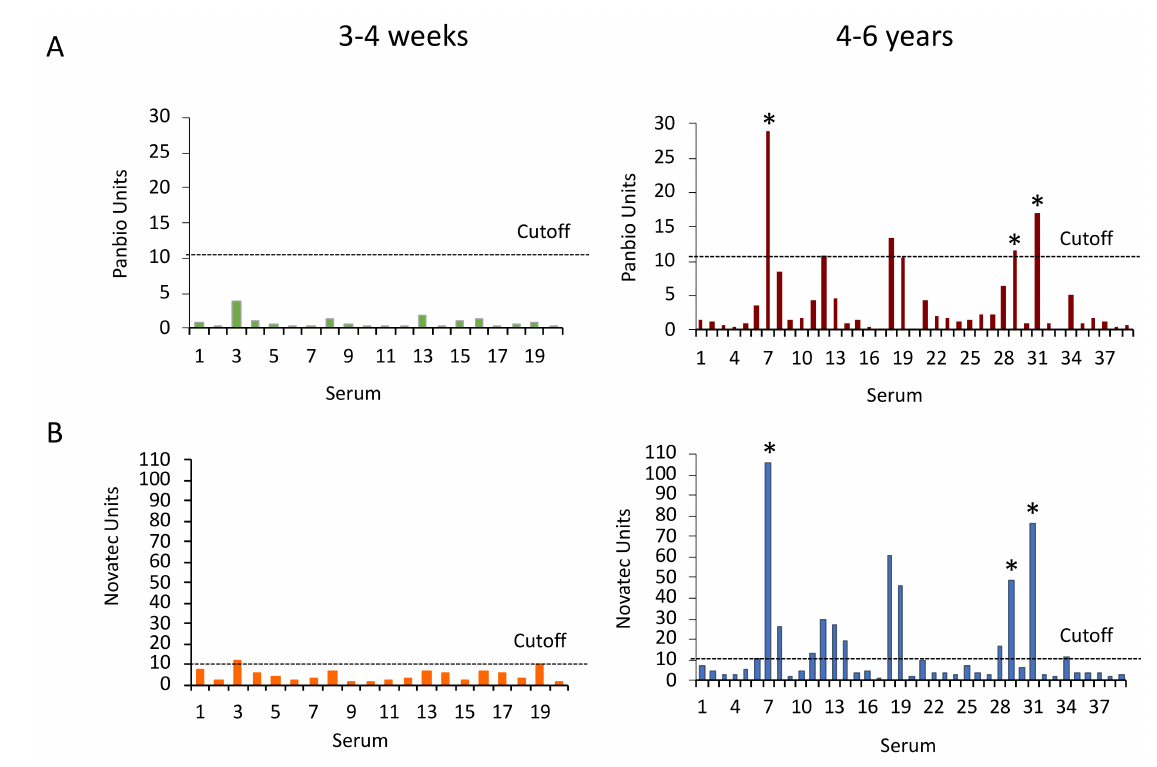
Figure 3. Panbio and NovaLisa Dengue IgG ELISA reactivity with sera from YFV-vaccinated individuals. ( A ) Panbio and ( B ) NovaLisa ELISA units with sera from 3–4 weeks (N = 20) and 4–6 years (N = 39) after YFV vaccination. Original Panbio measurement units were multiplied by 10. The dotted line indicates the cut-off for positive sera (11 assay units). Asterisks show sera that neutralized DENVs. Table 2. Diagnostic specificity of the Panbio and NovaLisa dengue IgG